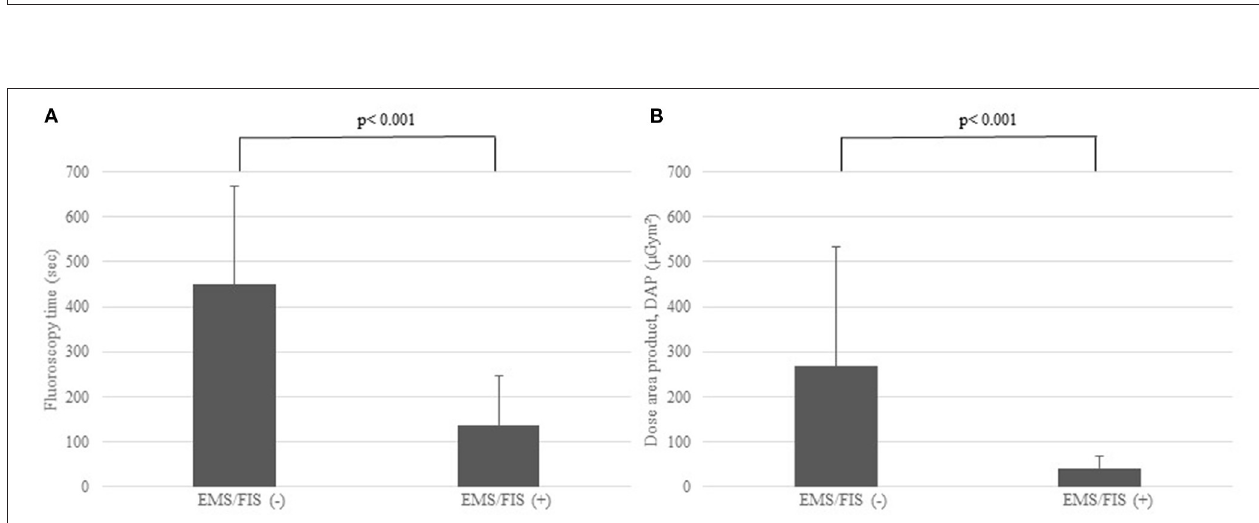
FIGURE 3 | (A) Significant reduction of fluoroscopy time (FT, sec) in the EMS/FIS( + ) vs. the EMS/FIS(–) group. (B) Significant reduction of dose-area-product (DAP, µ Gym ² ) in the EMS/FIS ( + ) vs. the EMS/FIS(–) group.